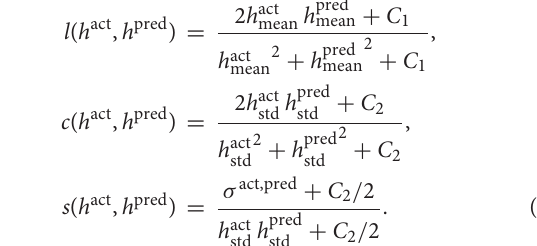
the elevation of each mesh grid is treated as an independent random